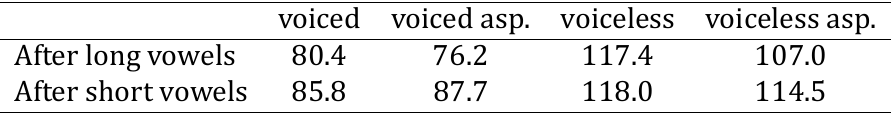
Table 8: Telugu stop closure durations (ms)